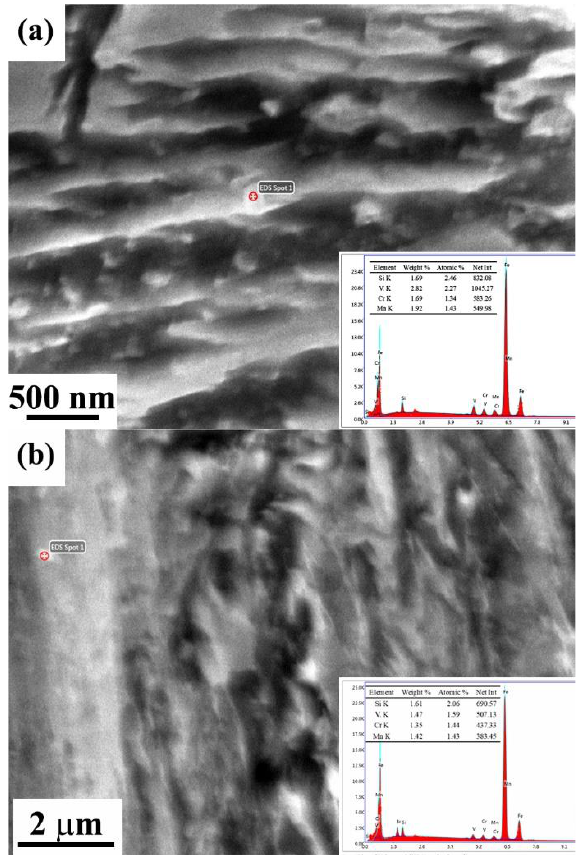
Figure 7. EDS analysis of specimen treated at 950 °C – 870 °C and 950 °C – 848 °C ( a , b ) .